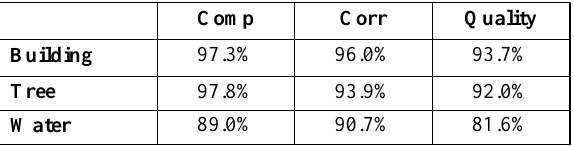
Table 3. Accuracy assessments of Building, Tree and Water classes in Eisenstadt region.